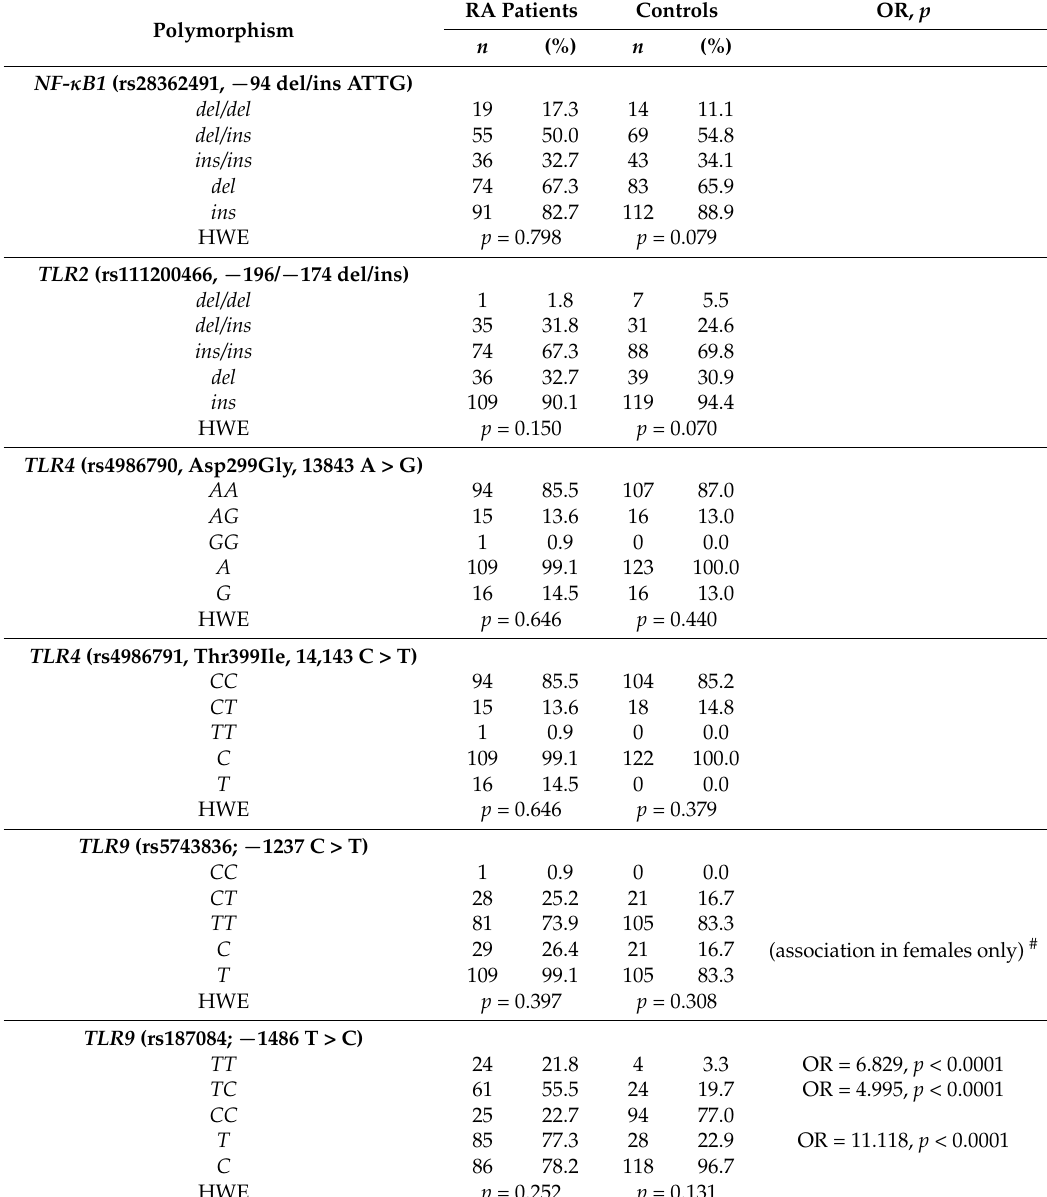
Table 3. Distribution of the TLRs and NF- κ B1 alleles and genotypes in Polish patients with rheumatoid arthritis and healthy individuals. The TLR2 and TLR9 polymorphisms were associated with predisposition to RA. HWE stands for Chi 2 p -values calculated for Hardy-Weinberg Equilibrium